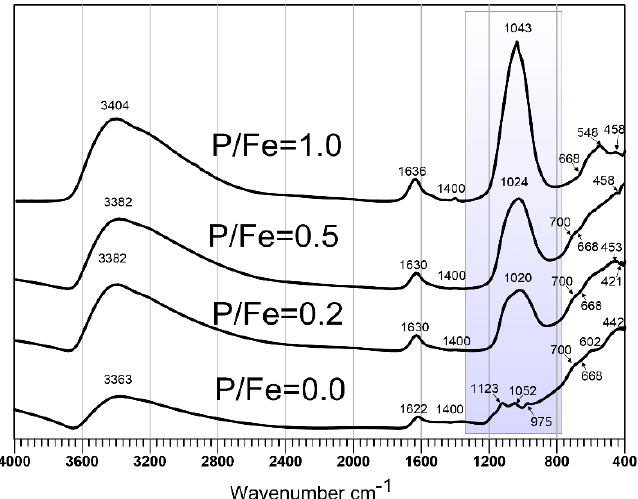
Figure 3. Background-corrected FTIR spectra of synthetic P-free and P-doped ferrihydrites (before heating). The bands in the shaded area indicate the presence of PO 43 − . The position of this band shifts slightly toward higher wavenumbers with the increase in P content.